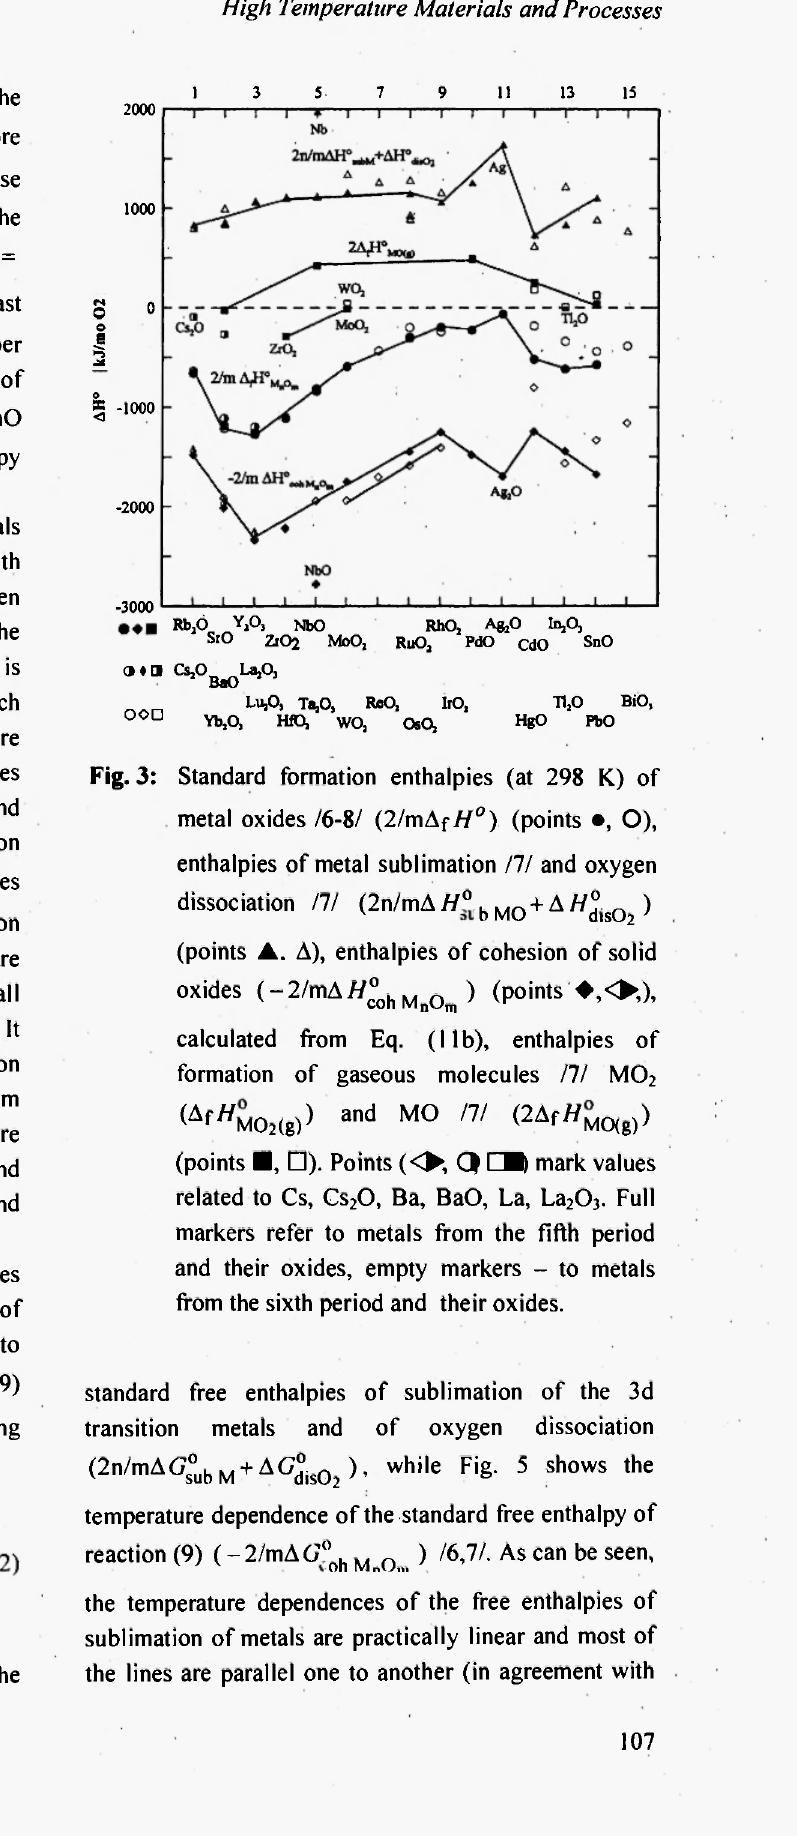
markers refer to metals from the fifth period and their oxides, empty markers - to metals from the sixth period and their